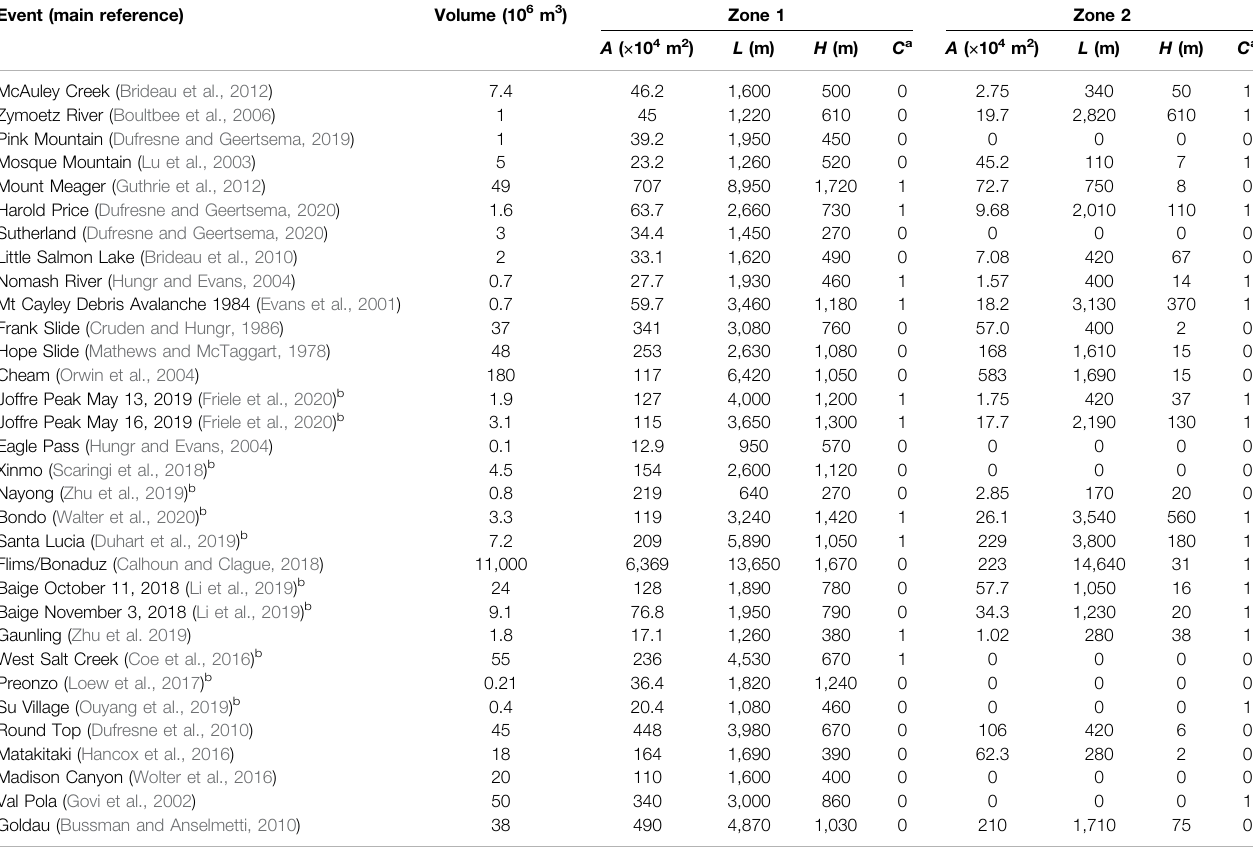
TABLE 2 | Summary of case histories. Event (main